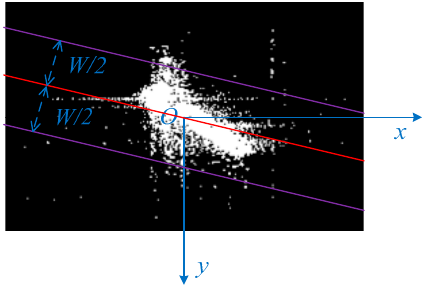
l norm regression. Figure 5. The principal axis extracted through the l 1 1 norm